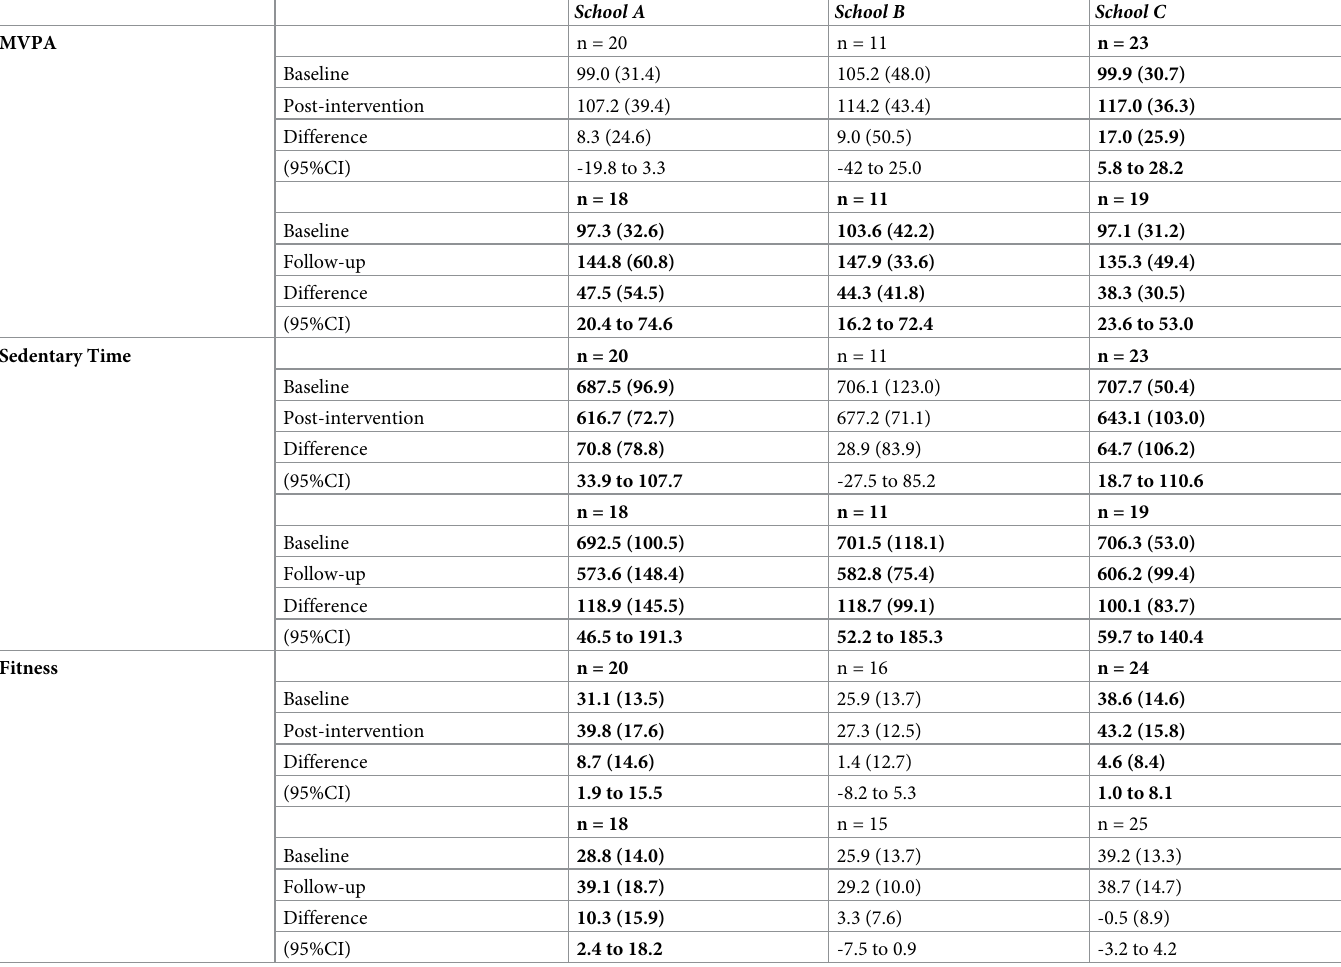
Table 2. Changes in MVPA, sedentary time and fitness per school between baseline, post-intervention and follow-up.